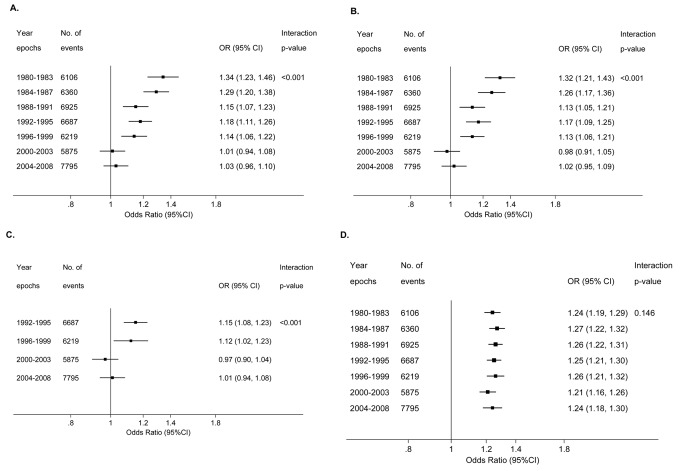
Forest plots of odds ratios for preterm birth in Scotland by epoch.(A) Unadjusted odds ratio for a one-unit increase in number of previous abortions (coded as 0, 1, 2, and 3 or more) in relation to risk of preterm first birth among 732,719 women for births from 1980 to 2008. (B) As in (A), but odds ratio adjusted for maternal characteristics (deprivation category, previous miscarriage, maternal age, height, and marital status). (C) Adjusted odds ratio for a one-unit increase in number of previous abortions in relation to risk of preterm first birth among 414,373 women for births from 1992 to 2008. Odds ratios adjusted for maternal characteristics as in (B), but also for smoking. (D) Adjusted odds ratio for a 10-cm decrease in maternal height in relation to the risk of preterm first birth among 732,719 women for births from 1980 to 2008. Odds ratios adjusted for deprivation category, maternal age, marital status, previous abortion, and previous miscarriage. The interaction p-value is for a Wald test of the null hypothesis that the odds ratios did not significantly differ across the period 1980 to 2008. Year is treated as a continuous variable in all the statistical tests of interaction.